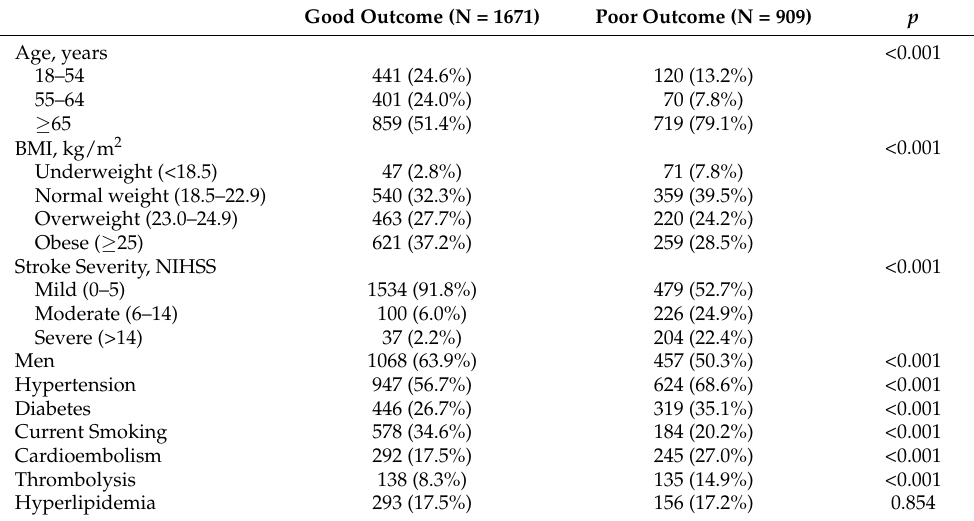
Table 3. Comparison of baseline characteristics of the participants.